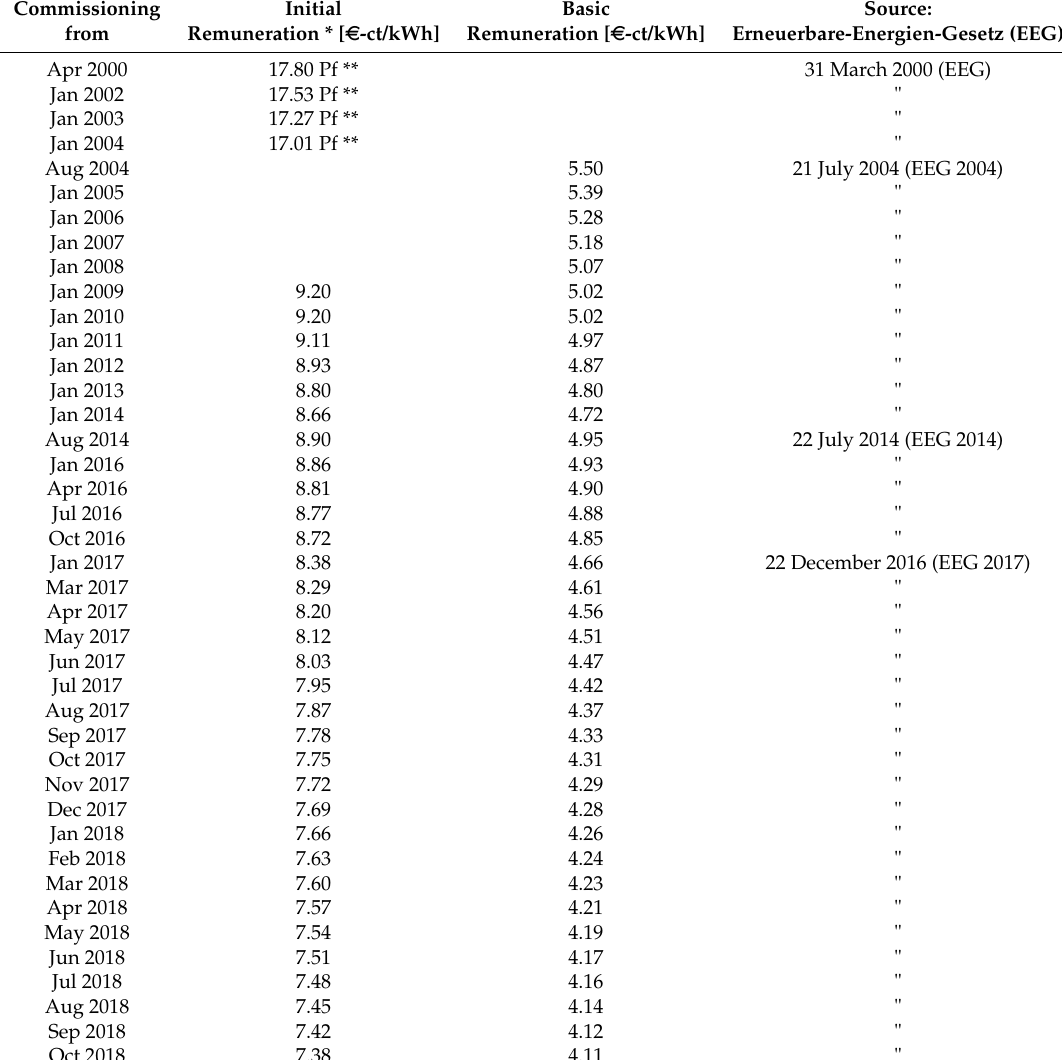
Table A1. Development of EEG remuneration for onshore wind power plants.